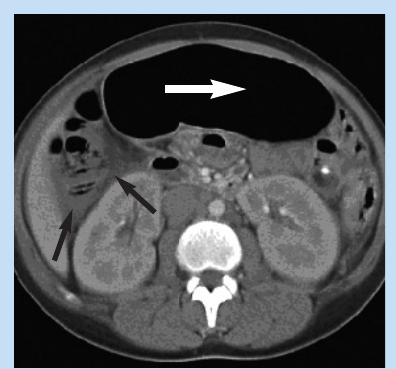
Fig. 3. Contrast-enhanced CT scan at the level of the mid-upper poles of the kidneys demonstrates pericolic inflammatory strand- ing (black arrows) surrounding the colon, proximal to hepatic flexure, in the anterior pararenal space.Note the distended stomach anteriorly (white arrow).